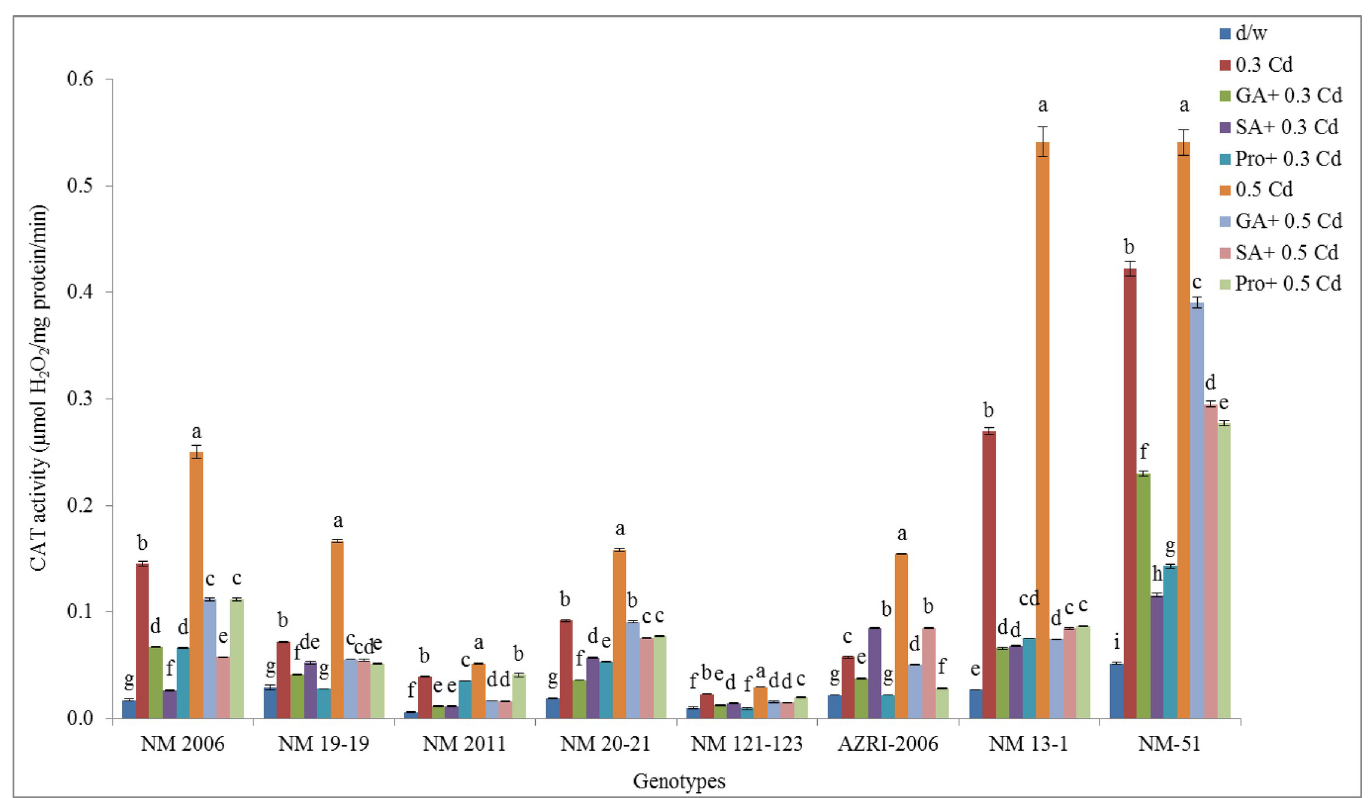
Fig 10. Catalase activity of mung bean grown under Cd and pretreatments of GA 3 , SA and proline prior to Cd.